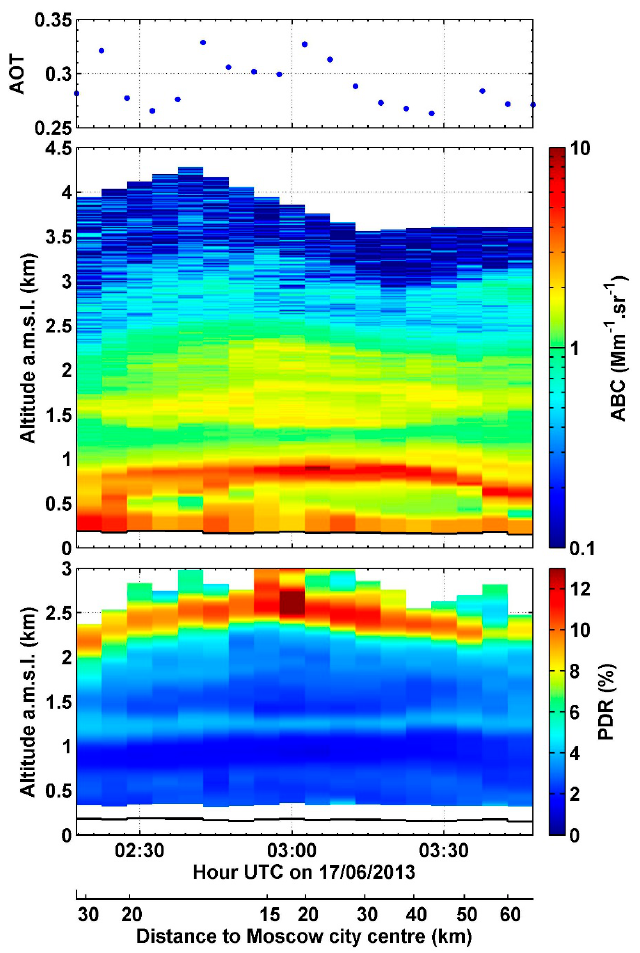
Figure 7. Same as Figure 4 but above Moscow on the early morning of Monday 17 June 2013. The 5-min average profiles are inverted using the LR profile from Figure 6a. The point used to compute the distance from the city center is the Red Square. Local time is UTC+4.